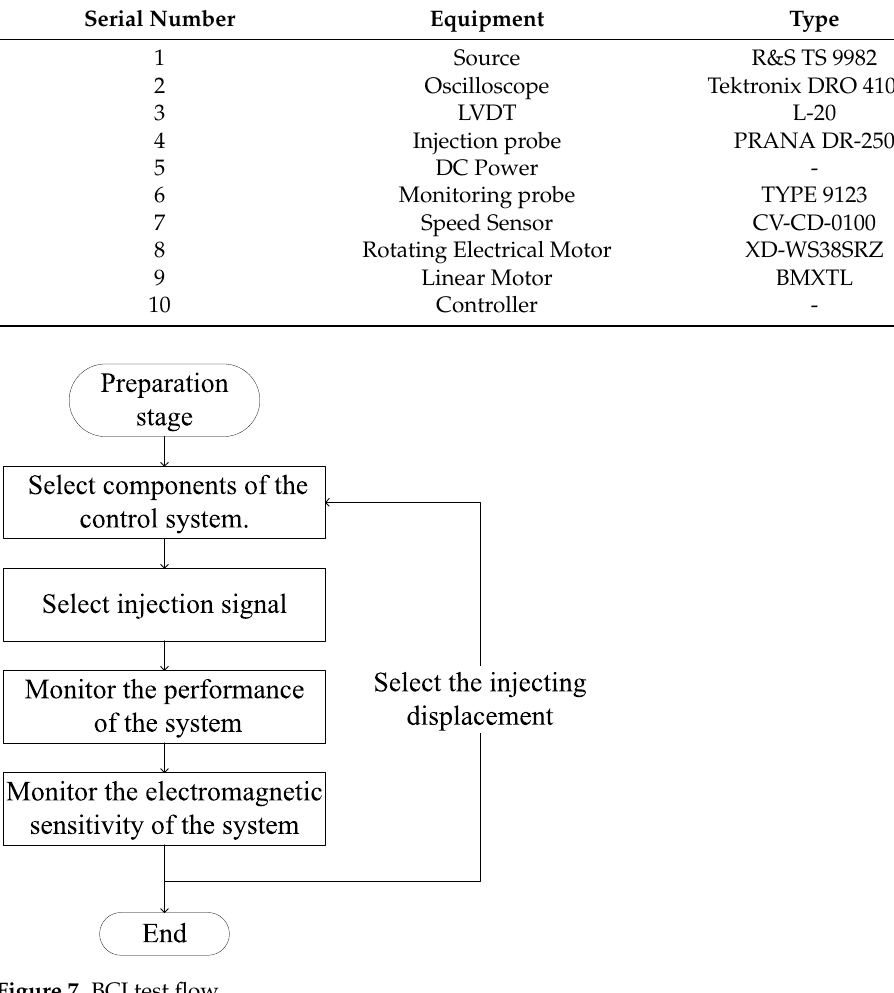
Figure 6. Bulk current injection test layout. Table 1. Bulk current injection test equipment.